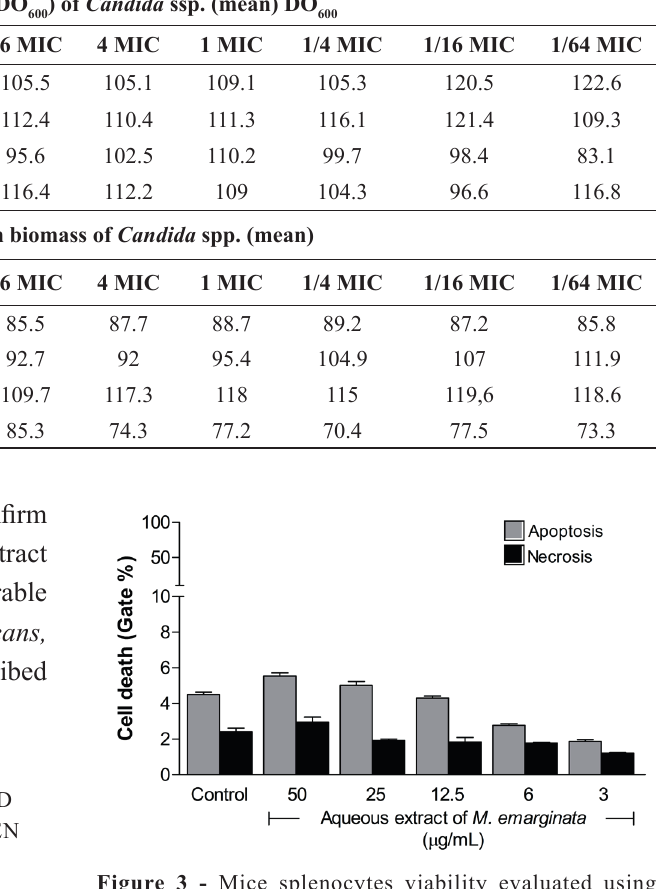
Figure 3 - Mice splenocytes viability evaluated using annexin V and propidium iodide staining. Saline extract from M. emarginata leaves did not promoted cell death in none concentration. Horizontal bars represent the average of three independent experiments performed in duplicate. Results were evaluated in the significance level of